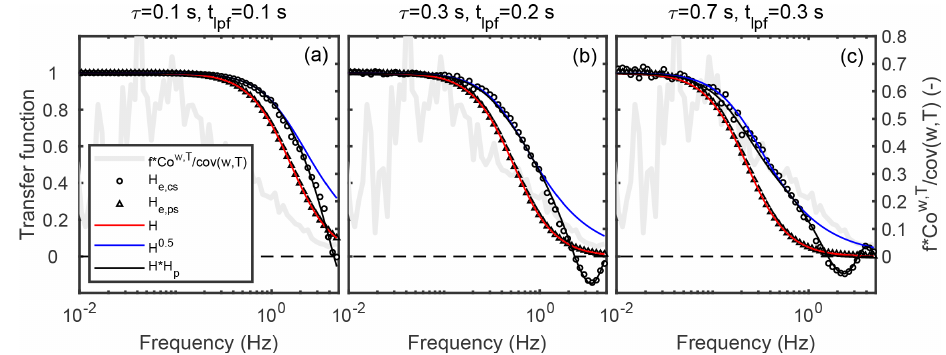
Figure 4. Transfer functions (left y axes) and frequency-weighted and normalised cospectrum (right y axes) for the same data shown in √ H and HH p were not fitted but calculated using the known values for τ and t lpf resulting from the low-pass Fig. 3. Note that here H , filtering of the T time series (Sect. 3.2.2). Nevertheless, H is related to Method 1, H 0 . 5 to Method 3 and HH p to Method 4 (see Table 1). Note also that the cospectrum shown in the figure was calculated from the unattenuated T time series in order to demonstrate the frequency range making the biggest contribution to the flux.